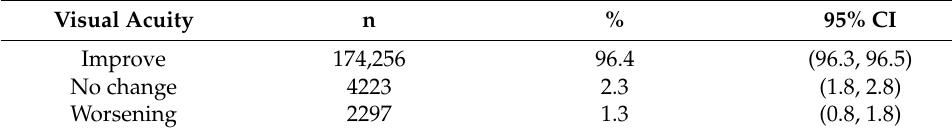
Table 1. Proportion of improvement in VA among cataract patients in